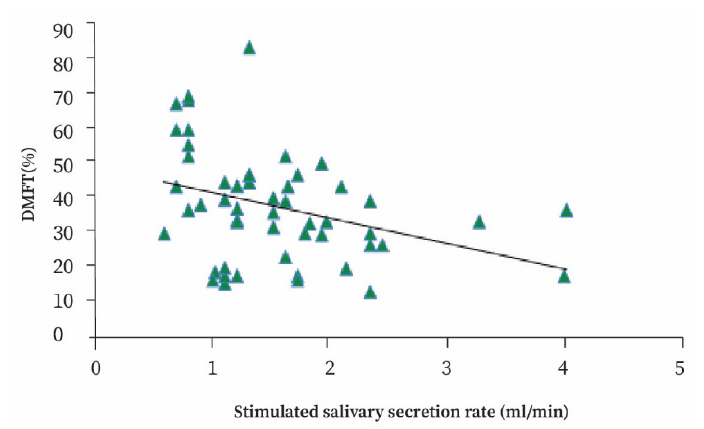
Figure 2. DMFT variation as a function of the ratio of the stimulated salivary flux (ml/min) .